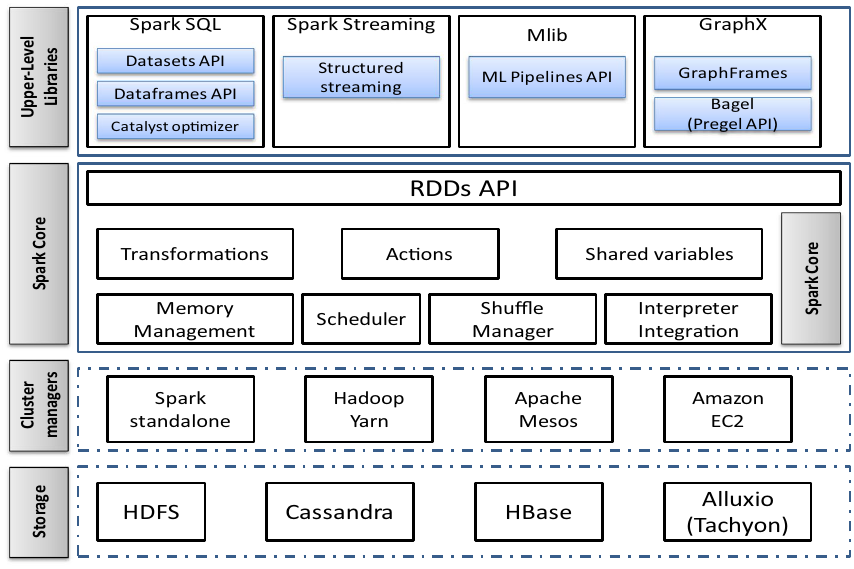
Fig. 7 The Apache Spark stack architecture